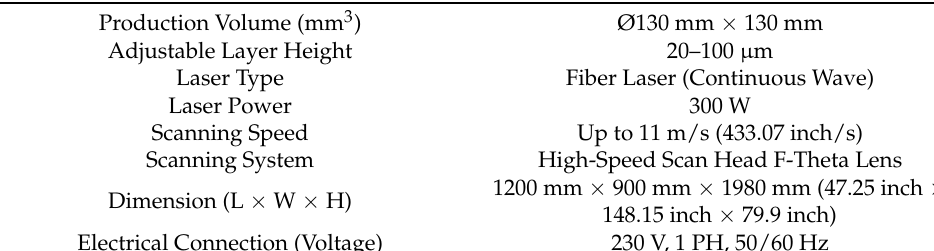
Table 4. Technical specification ERMAKSAN ENAVISION 120.